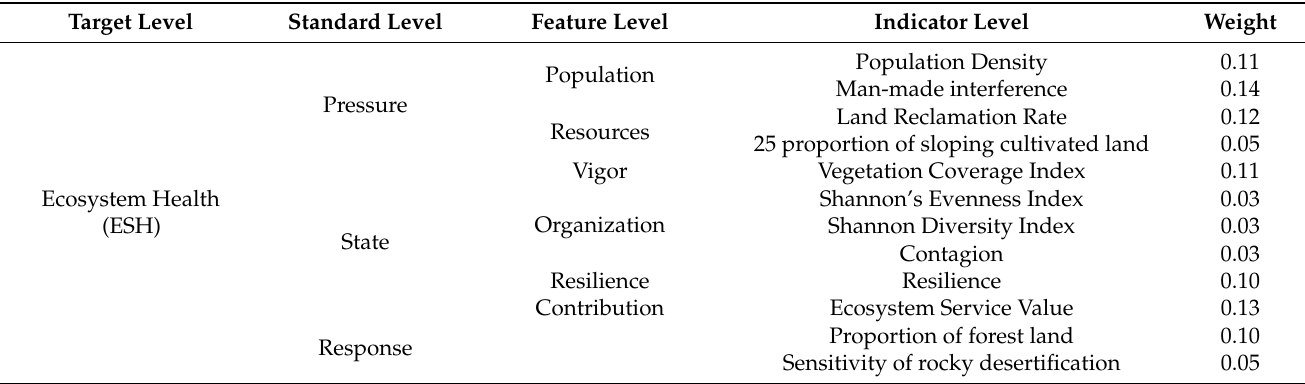
Table 2. Index system of the ecosystem health evaluation and their